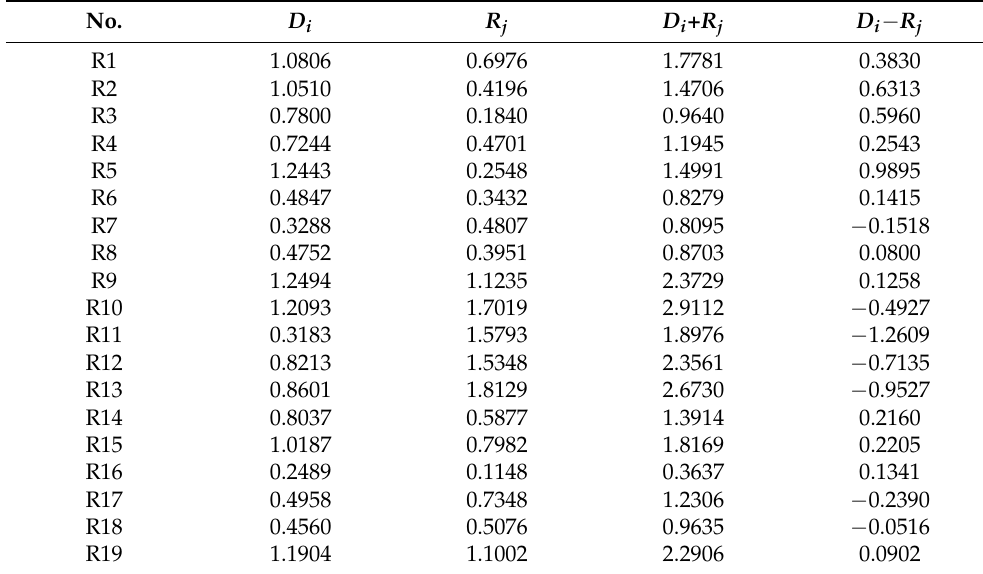
Table 13. Prominence vector ( D i + R j ) and relation vector ( D i − R j ) of SSCRs.